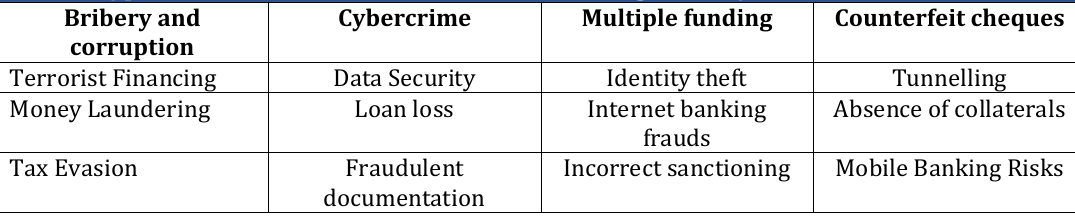
Table 1: Types of Frauds Prevalent in the Indian Banking Industry Bribery